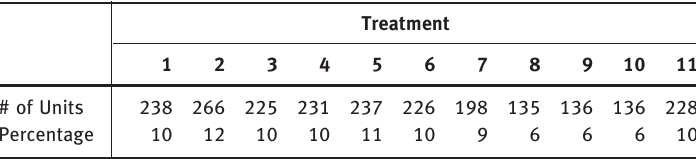
Table 4: Number of units assigned to each treatment level : The number of units assigned to each treatment level was relatively